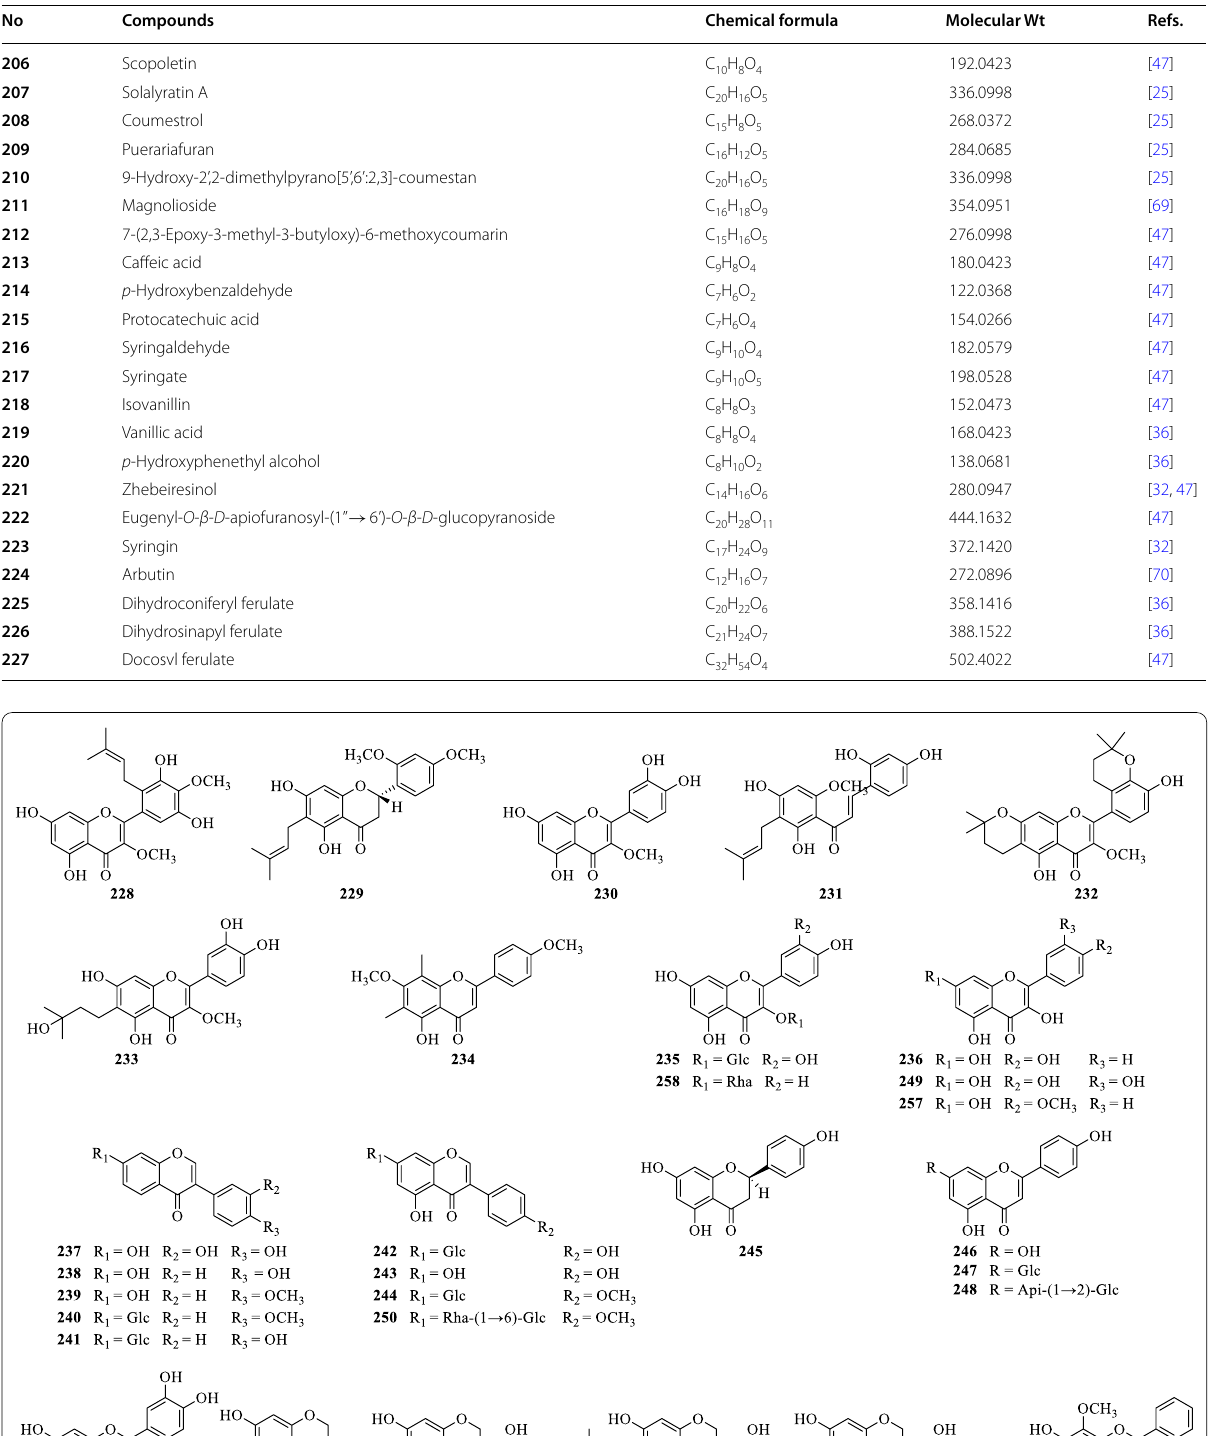
Table 10 Coumarins, simple phenylpropanoids and their derivatives isolated from S. lyratum